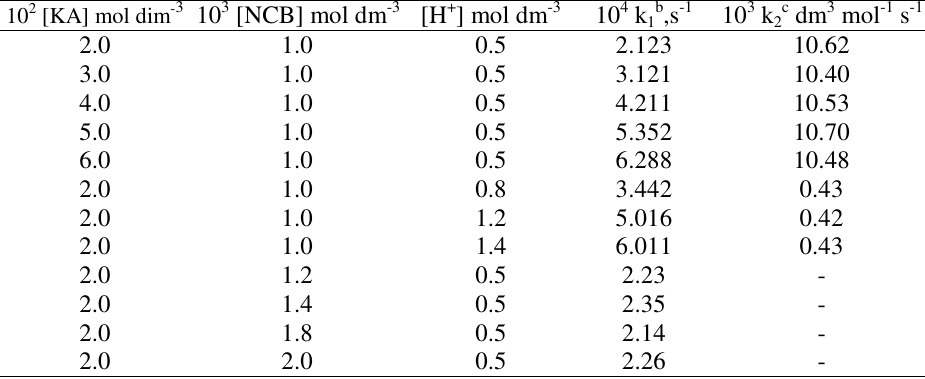
Table 1 . Rate constant for the oxidation of 3-benzoylpropionic acid by NCB in aqueous acetic acid medium at 30 0 C